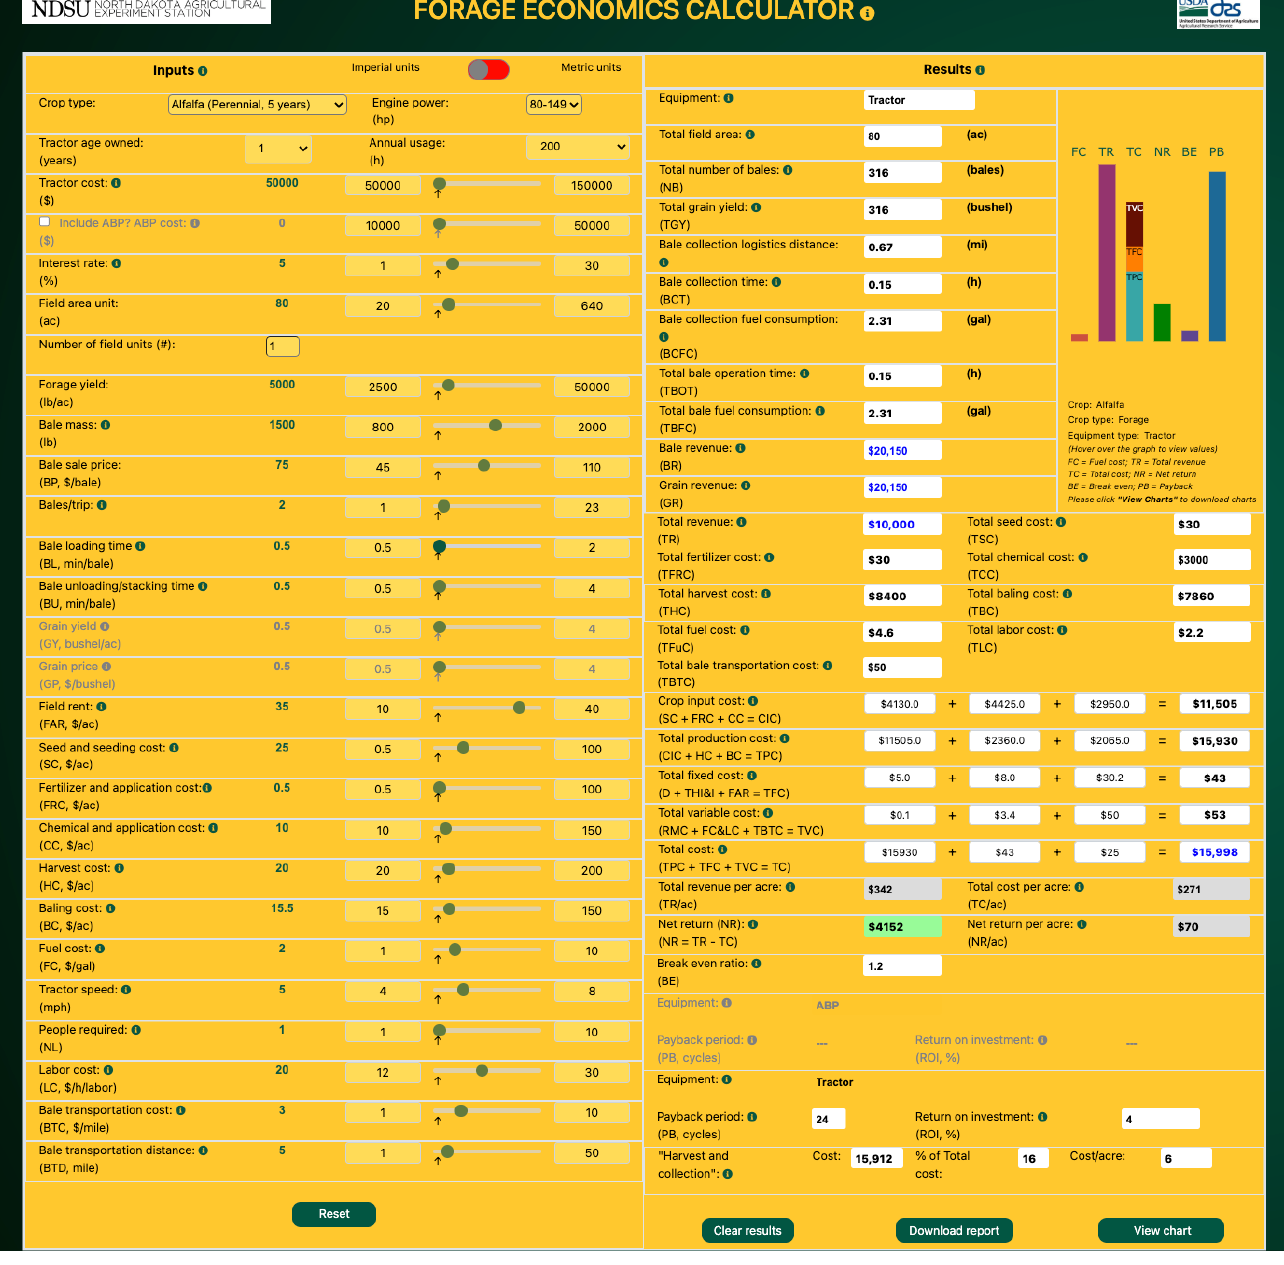
Figure 15. Forage economics calculator developed by North Dakota State University and NGPRL, USDA-ARS, Mandan, ND. Yellow textboxes indicate inputs and the white, gray, and green textboxes the outputs at different